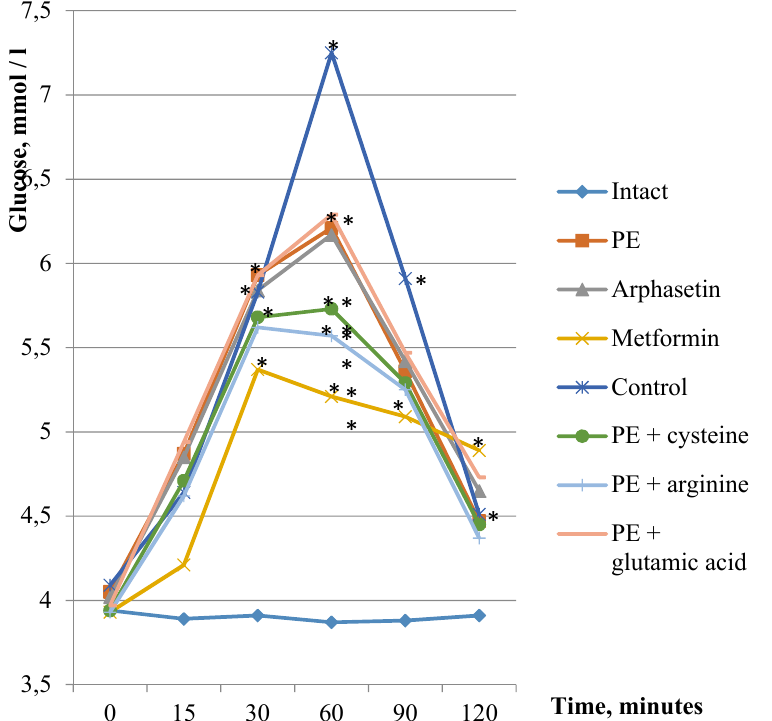
Fig. 2. The results of OGTT with the administration of dry extract of bearberry leaves and dry extract with the addition of amino acids: *– p ≤ 0.05 compared to intact; ** – p ≤ 0.05 compared to control